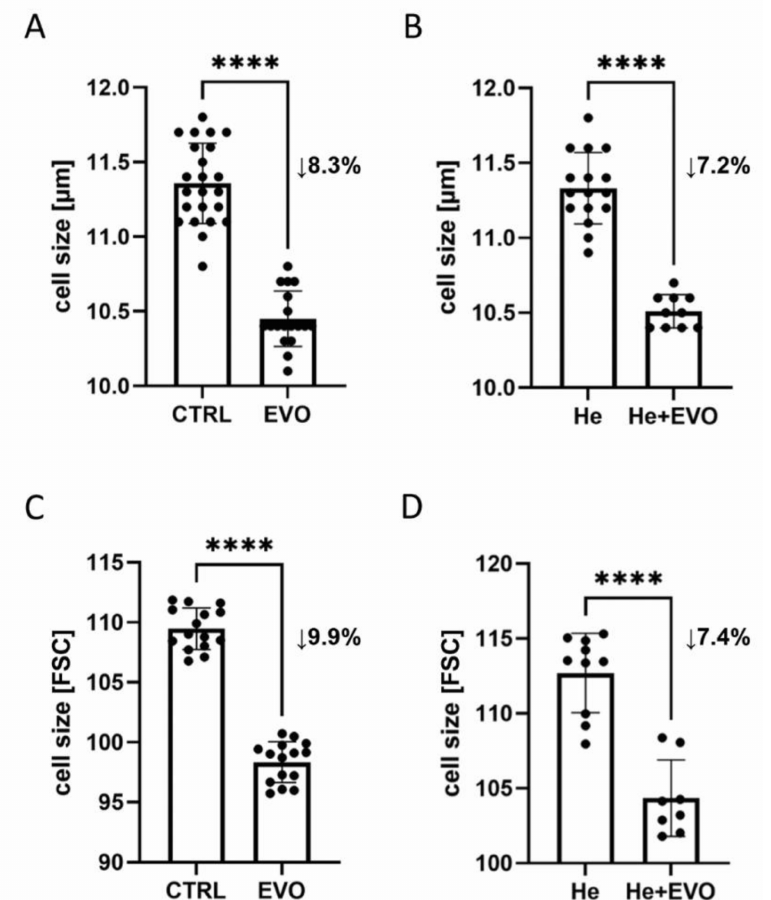
Figure 3. Effect of everolimus on the size of K562 cells in the presence or absence of iron. K562 cells (1 × 10 5 cel/mL) were exposed to 5 µ M everolimus alone ( A , C ) or in combination with 40 µ m hemin ( B , D ) for 72 h, and differences in cell size were evaluated by the use of an automated cell counter ( µ m) and flow cytometry (FSC-A). CTRL—vehicle only (0.05% DMSO); EVO—5 µ M everolimus; He—40 µ M hemin; He + EVO—40 µ M hemin + 5 µ M everolimus. The results shown are the mean ± SD of three separate experiments done in triplicate. Significant differences compared to the control group are presented, **** p < 0.0001 (paired t -test for ( A – C ), Wilcoxon matched-pairs signed-rank test for ( D